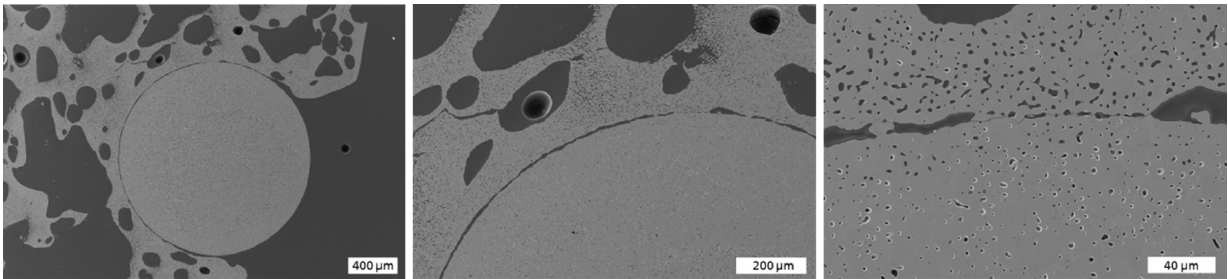
Figure 5. FESEM cross-cutting images displaying interface between VPP-manufactured column and Freeze Foam; magni- fication/HFW 35×/3334 μ m ( left ); 100×/1160 μ m ( middle ); 500×/242 μ m ( right ); 8 kV acceleration voltage.